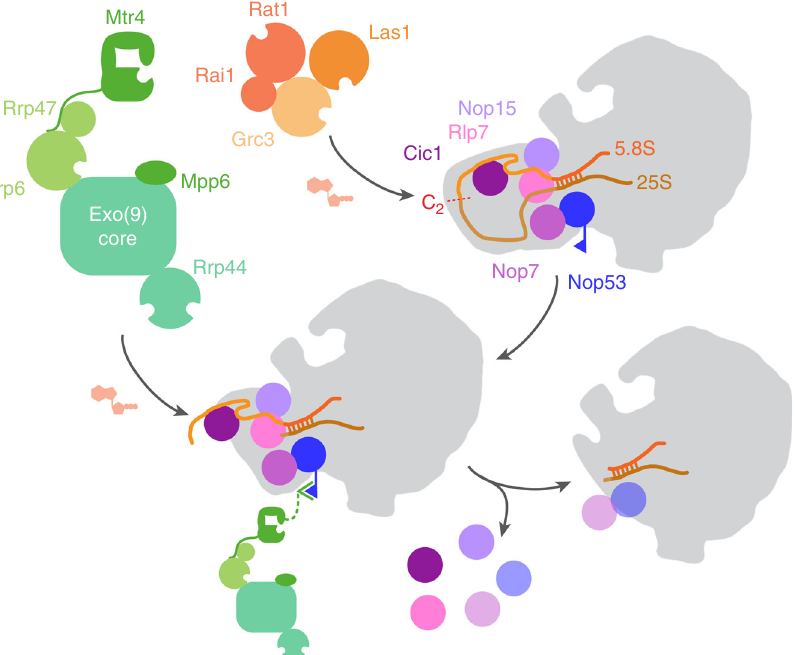
Fig. 6 Scheme of ITS2 removal from pre-60S particle based on in vitro C 2 cleavage and 26S → 25S ’ pre-rRNA trimming by the Las1 complex, and 7S → 5.8S pre-rRNA processing by the nuclear exosome. The Las1 complex initiates ITS2 processing by C 2 cleavage and degrades the resulting 26S pre-rRNA to 25S ’ pre-rRNA, which facilitates processing of the 7S pre-rRNA by the exosome. The exosome interacts with the pre-60S particle via Mtr4 interaction with Nop53. Mtr4 interacts with a composite surface of Rrp47 and Rrp6 on the exosomal side. Processing of 7S pre-rRNA releases the ITS2-associated factors like Cic1 and Rlp7 ef fi ciently, or like Nop53 and Nop7 only